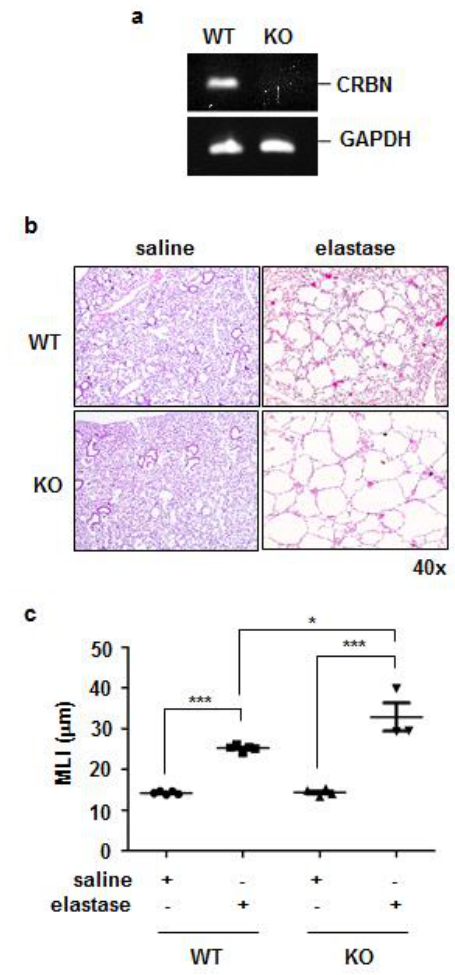
Figure 2. Crbn KO exaggerated elastase-induced emphysema in mice. WT and Crbn KO mice were given 0.5 units of elastase via intratracheal injection. (Day 14: WT-saline n = 5, WT-elastase n = 5, KO-saline n = 4, KO-elastase n = 3) ( a ) RT-PCR for Crbn and Gapdh in the lung tissues from WT and Crbn KO BALB/c mice. ( b ) Effect of Crbn deficiency on elastase-induced emphysema formation. Representative images of H&E staining in lungs from WT and Crbn KO mice 14 days after intratracheal instillation of elastase (×40). ( c ) The MLI was measured. Data represent means ± SE. * p < 0.05, and *** p < 0.001.